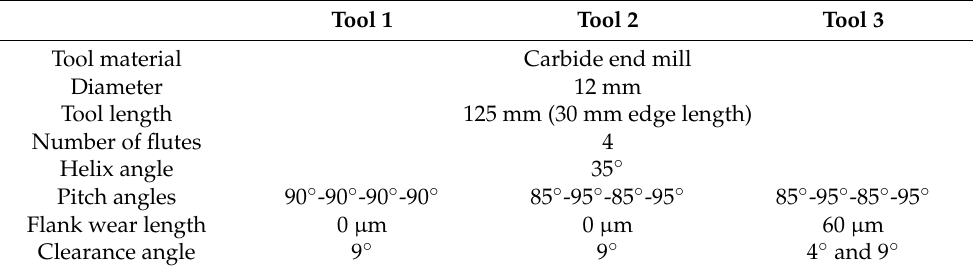
Table 1. Geometrical parameters of designed